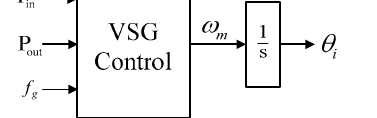
Figure 13. VSG control scheme.